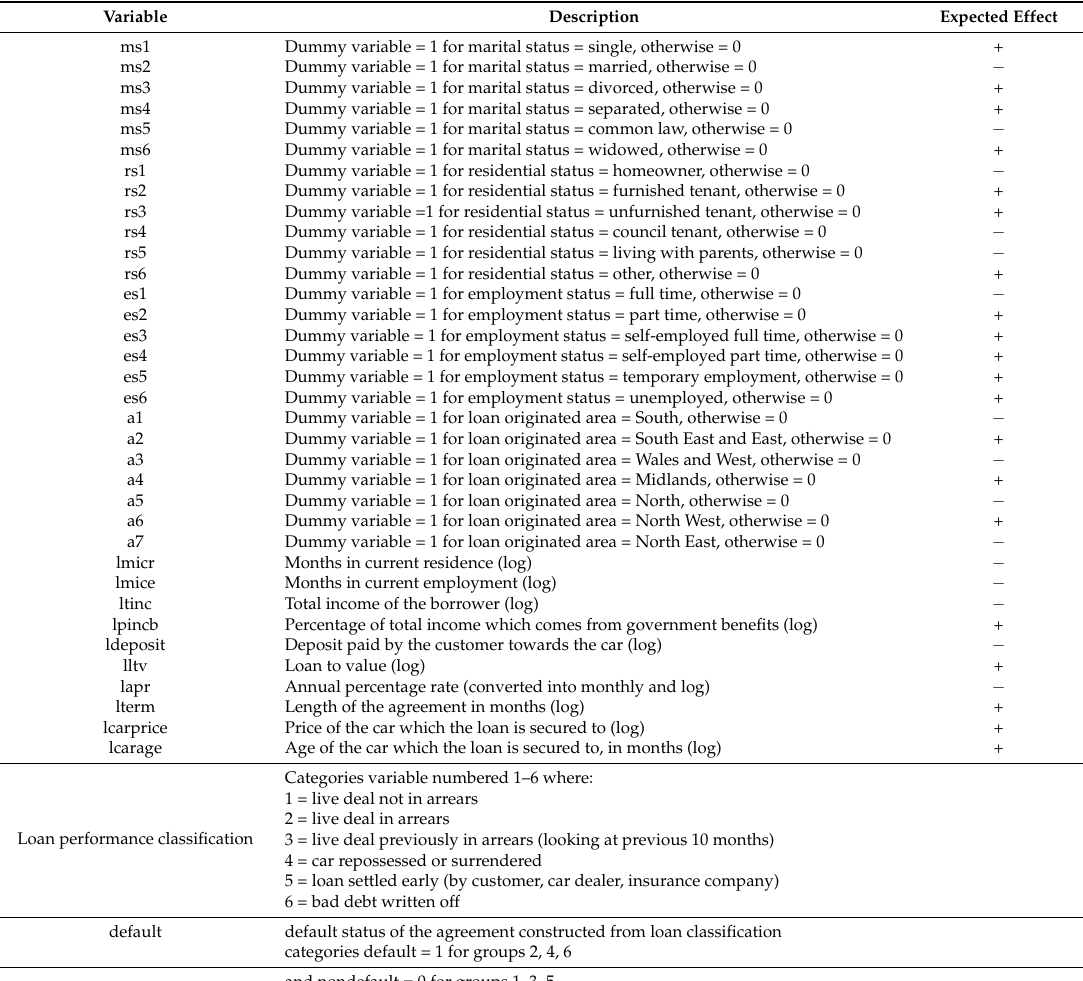
Table 1. Construction of default/arrears predictor